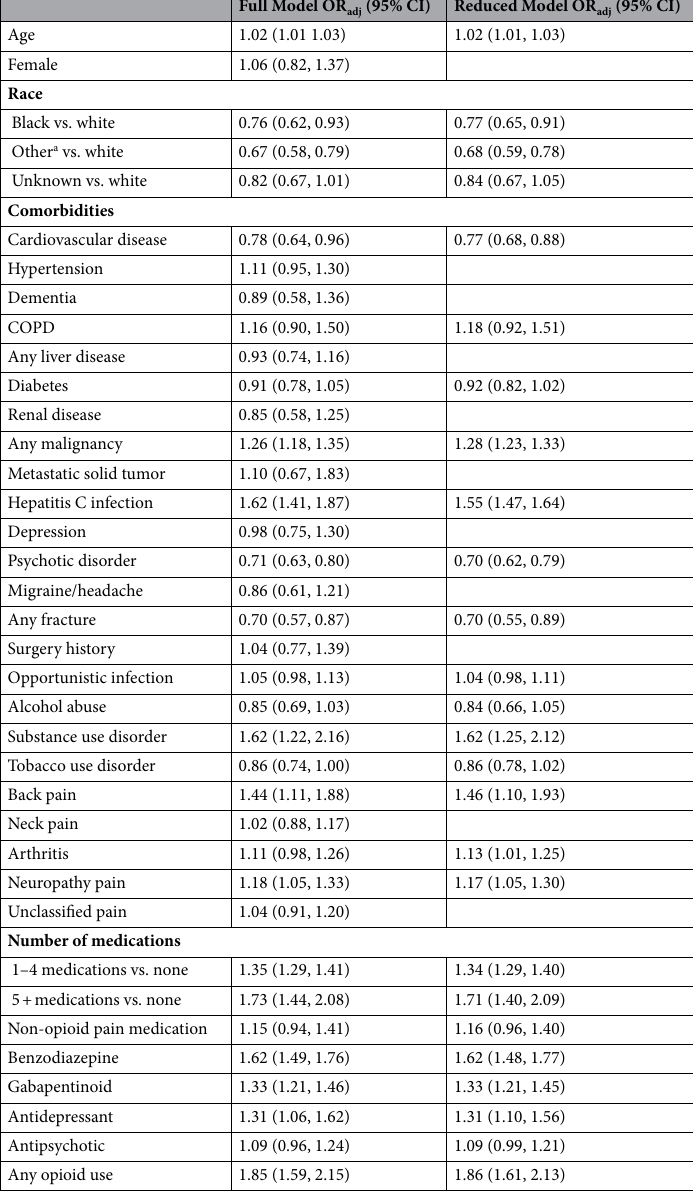
Table 2. Predictors of chronic opioid use vs. no chronic opioid use in Medicaid beneficiaries with HIV. a American Indian, Alaskan Native, Hispanic, Asian, Pacific Islander, Native Hawaiian, more than one race. Abbreviation COPD, Chronic pulmonary disease. Note Generalized estimate equation multivariable logistic regressions, accounting for clustering at the state level, were used and the reduced model was selected by backward